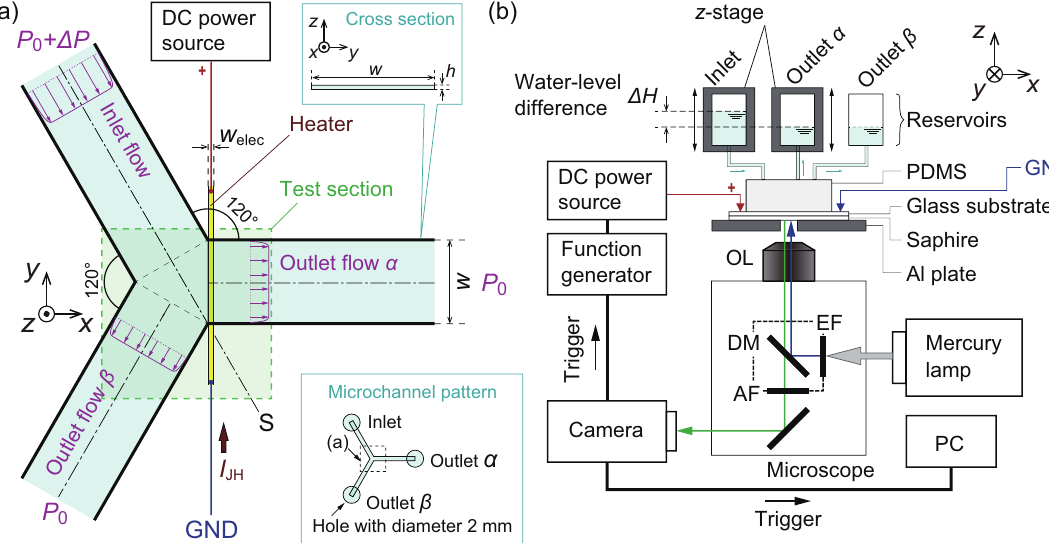
Figure 1. ( a ) Schematic of the test section. The branched microfluidic channel has a rectangular cross-section in the yz plane with a height h = 17.2 µ m and a width w = 450 µ m. The inlet flow is divided into two outlet flows α and β . A thin-film electrode heater is fabricated at the entrance of the outlet flow α . Flow profiles of the inlet and outlets are schematically drawn based on the analytical solution of the Poiseuille flow in a rectangular channel [58]. ( b ) Overview of the experimental setup. EF: emission filter. AF: absorption filter. DM: dichroic mirror. OL: objective lens. PC: personal